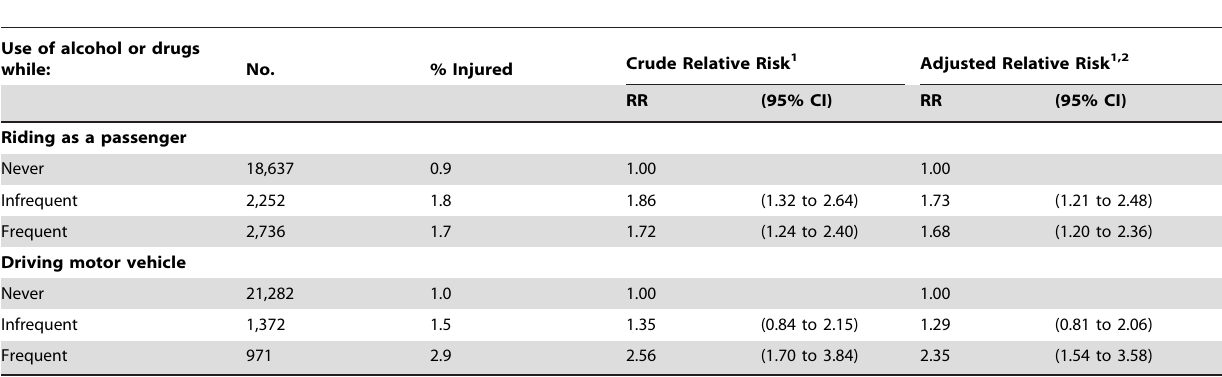
Table 4. Results of multiple logistic regression analysis examining direct effects of driving behaviours on risks for motor vehicle injury; 2010 Canadian HBSC survey.